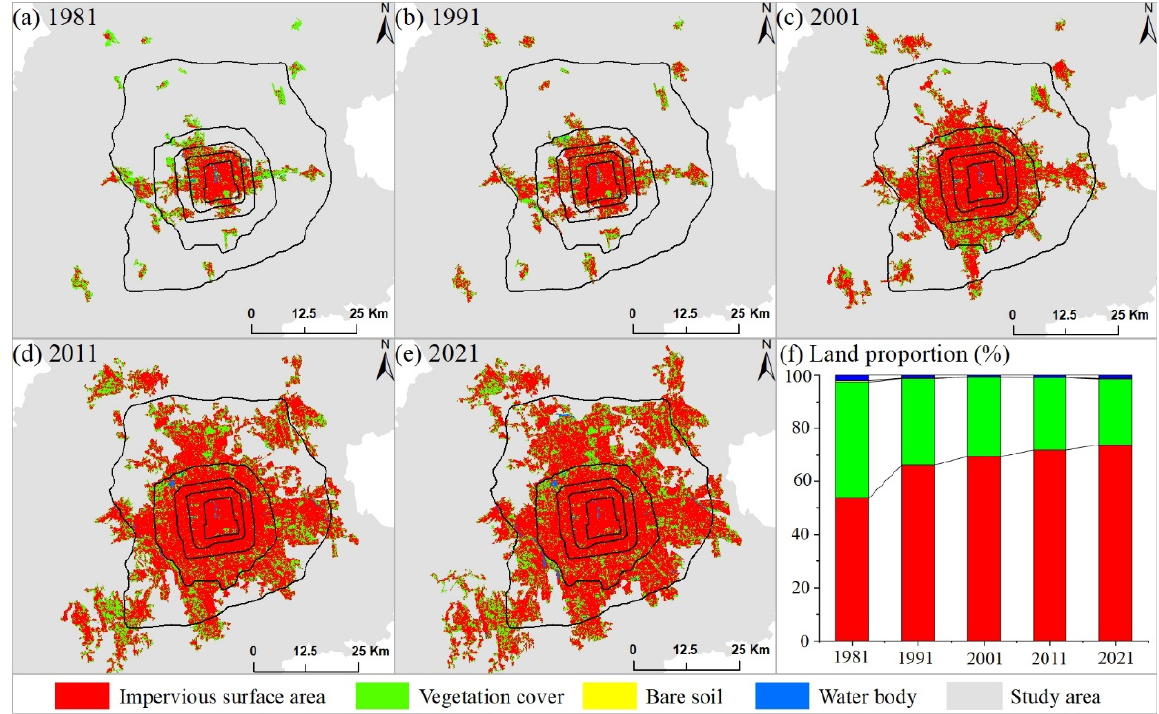
Figure 4. Spatial land structure changes and their statistics in Beijing from 1981 to 2021. Note: ( a – e ) represented the spatial structure of land use in Beijing in the years of 1981, 1991, 2001, 2011, and 2021, respectively; and ( f ) represented the statistics of land use changes during